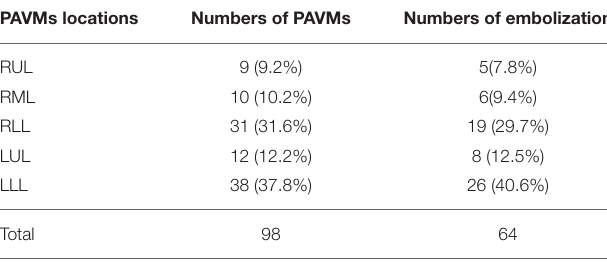
TABLE 5 | The locations and proportions of PAVMs by